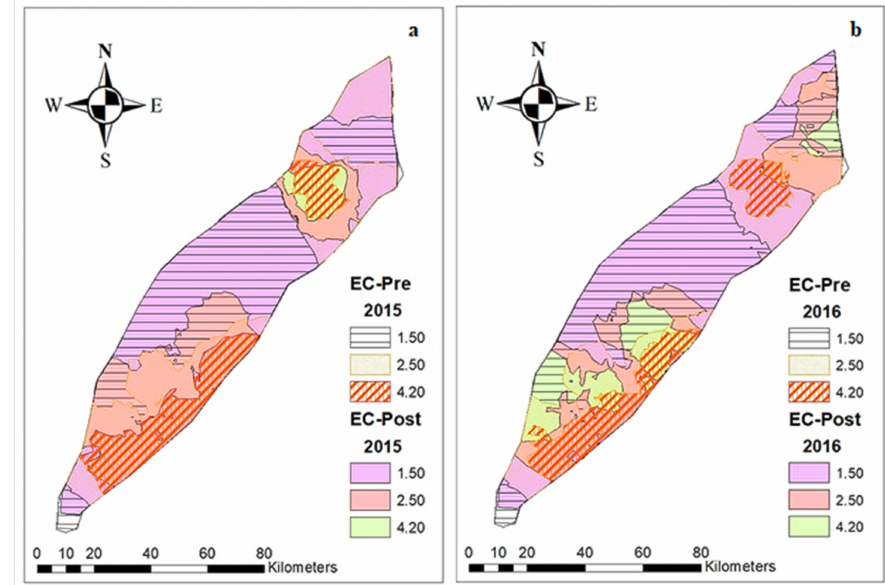
Figure 3. Overlay analysis of groundwater EC in pre-monsoon and post-monsoon season. ( a ) EC for 2015 and ( b ) EC for